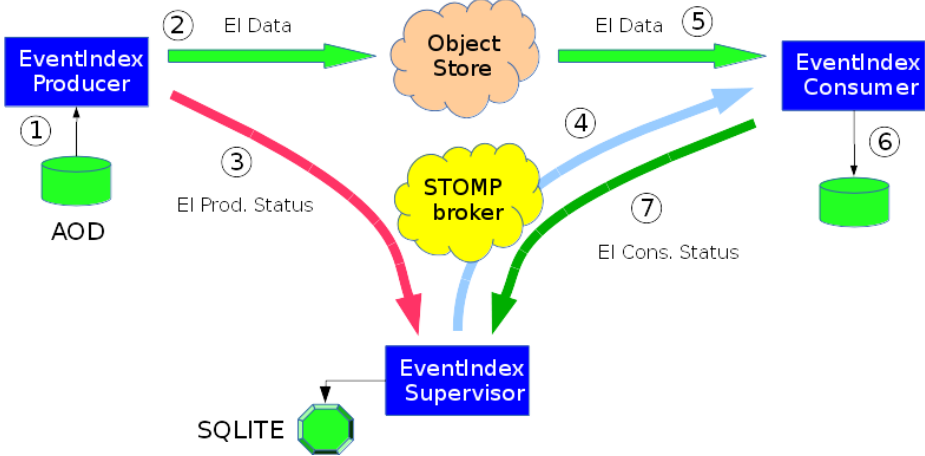
Figure 1: Distributed Data Collection